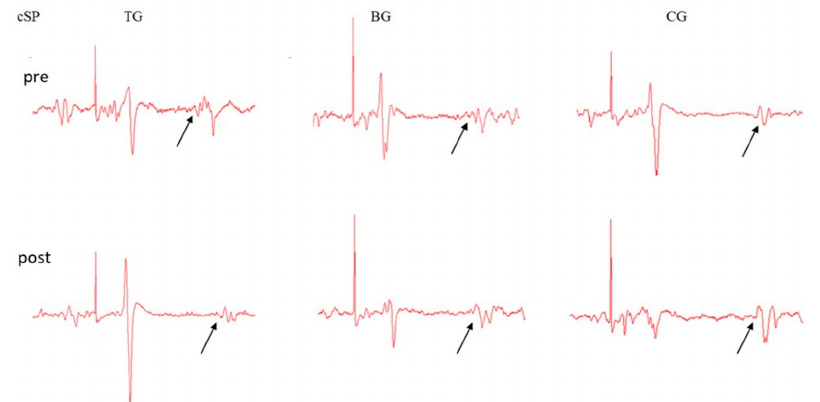
Figure 1. Raw data demonstrating the cortical silent period (cSP) lengthening of the cortical silent period from one participant pre and post tackle from the tackler group (TG), the ball carrier group (BG) and the control group (CG). The cSP was calculated from the test stimulus e artifact to the resumption of EMG activity indicated with an arrow. Brain Sci. 2020 , 10 , x FOR PEER REVIEW